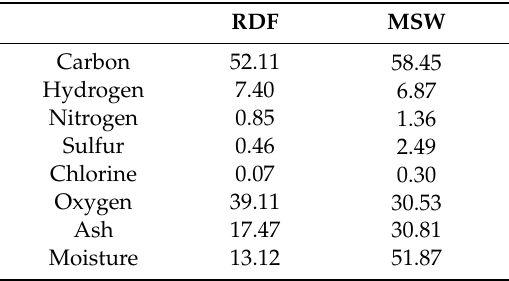
Table 1. Ultimate and proximate analyses of RDF and MSW (wt%)